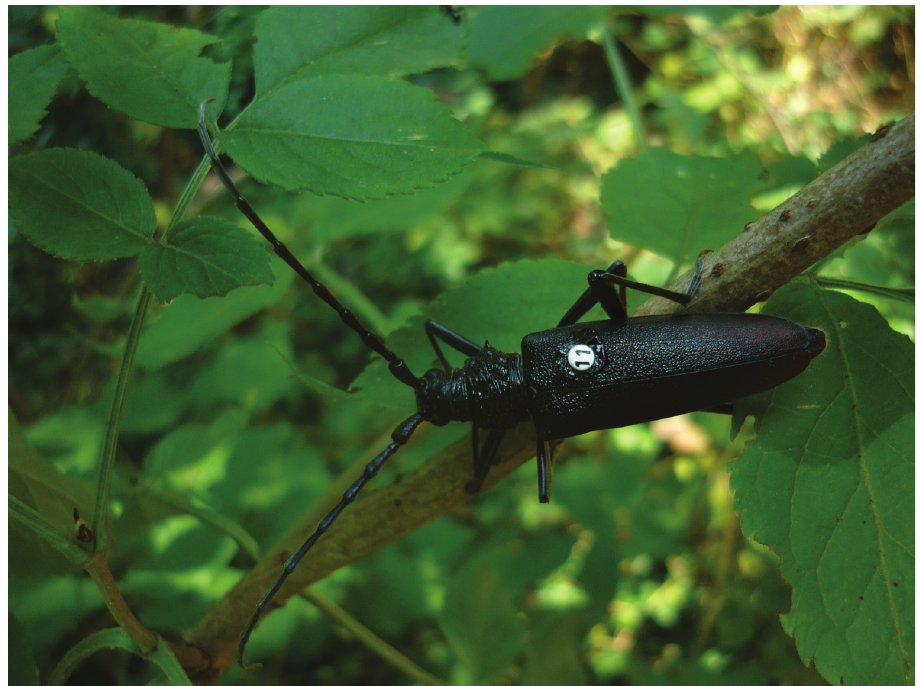
Figure 10. An individual of Cerambyx cerdo captured with a baited trap and bearing the glued tag (Photo by M.